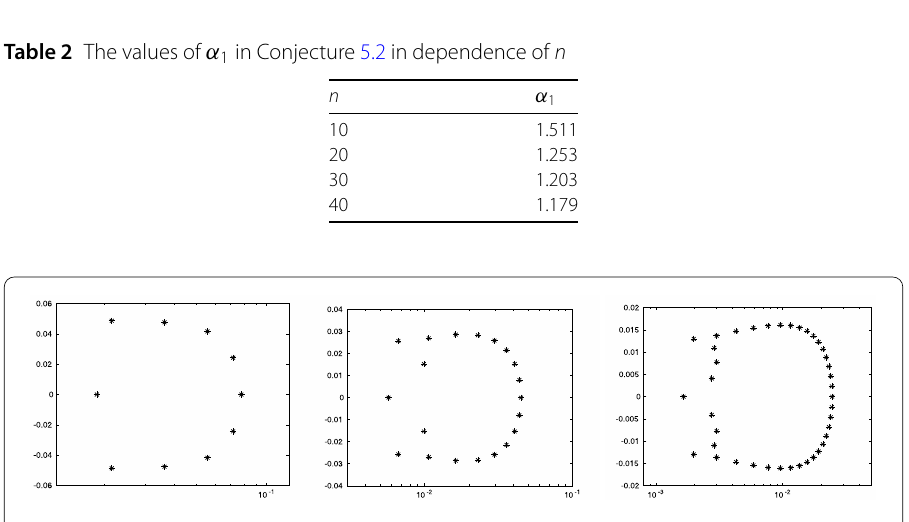
Figure 1 Eigenvalues of the matrix U n for a logarithmic weight function and n = 10,20,40 (from left to right)